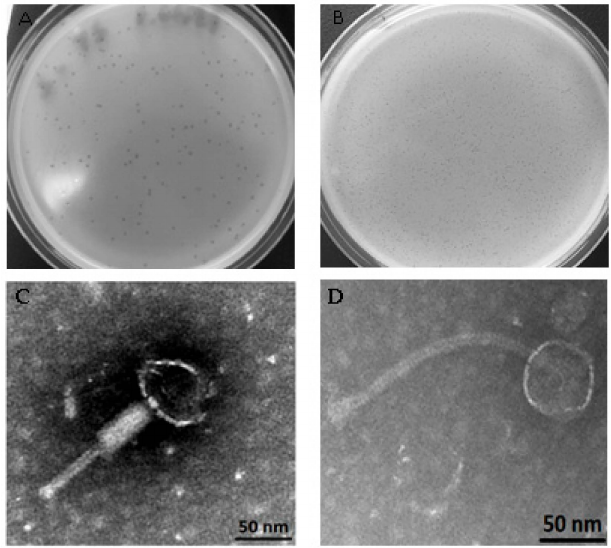
Figure 3. Plaque and virion morphologies of coliphage vB_EcoM_P5 ( A , C ) and staphylococci phage vB_SauS_P9 ( B , D